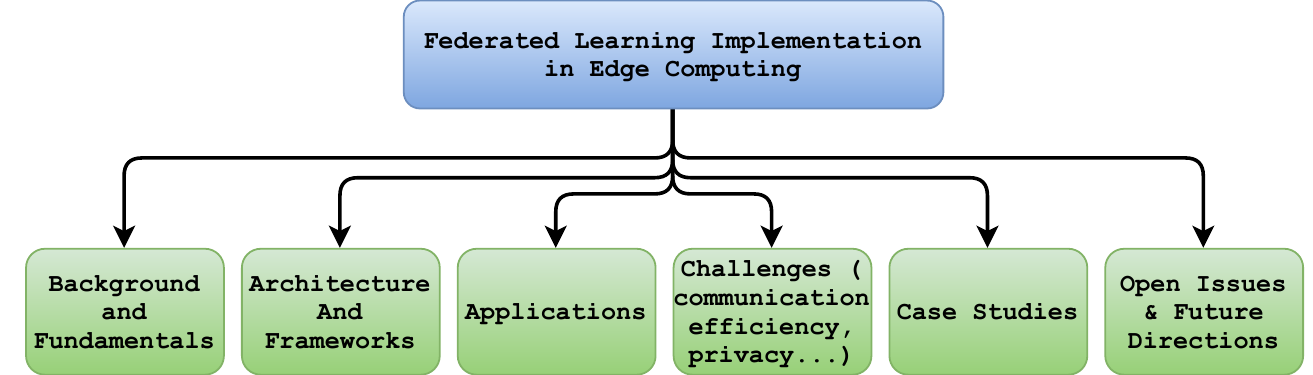
Figure 5. Taxonomy of federated learning in EC papers based on the high-level classification to be analyzed in this